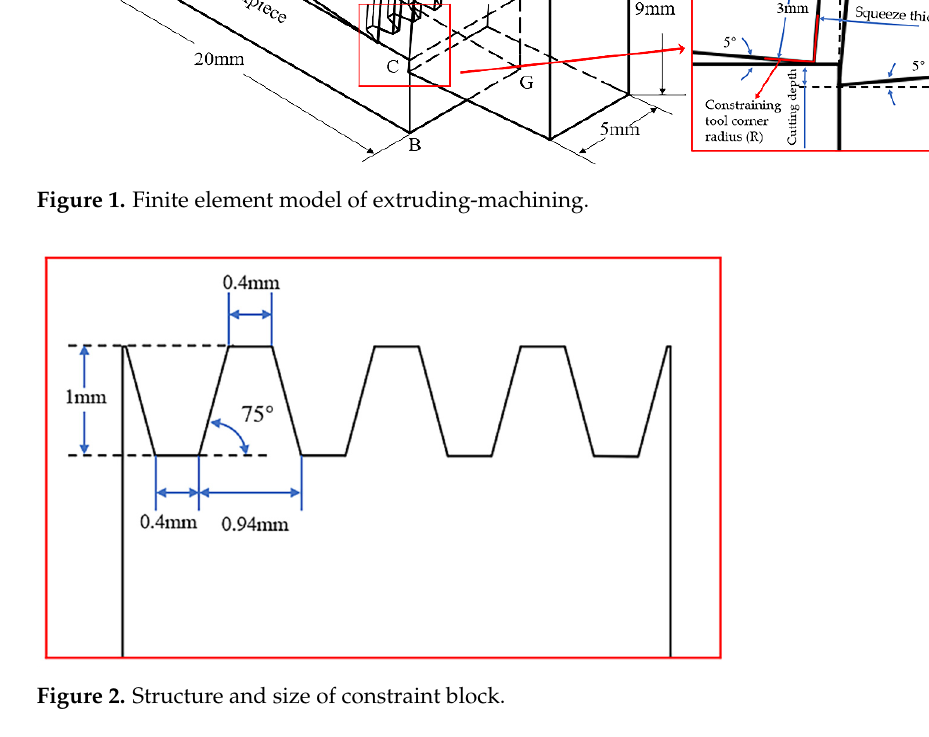
Figure 1. Finite element model of extruding-machining.